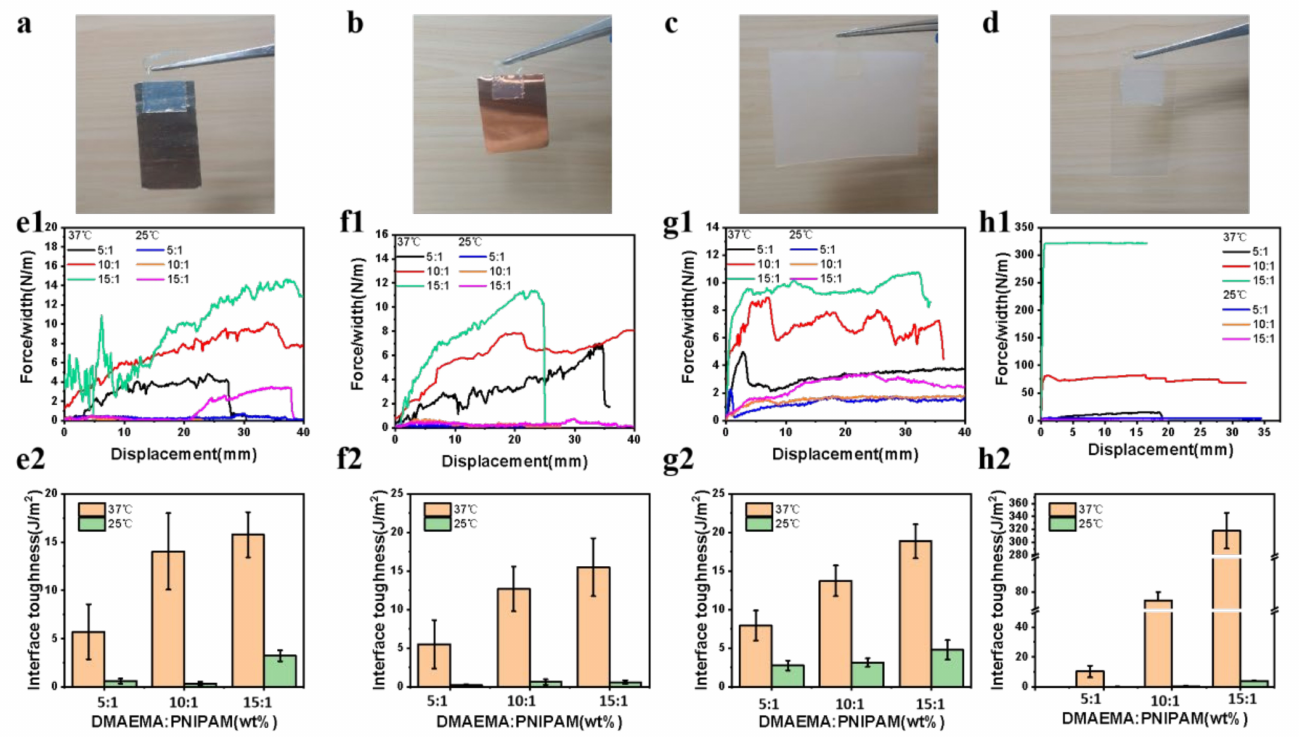
Figure 3. Adhesion performance of self-powered gradient hydrogel based on PDMAEAM/PNIPAM. Photos of hydrogels adhered on ( a ) platinum, ( b ) copper, ( c ) silicone rubber and ( d ) glass. ( e1 ) Peeling force curves and ( e2 ) interface toughness of hydrogel with different proportions at room temperature and high temperature in binding platinum; ( f1 ) peeling force curves and ( f2 ) interface toughness of hydrogel with different proportions at room temperature and high temperature in binding copper; ( g1 ) peeling force curves and ( g2 ) interface toughness of hydrogel with different proportions at room temperature and high temperature in binding silicone rubber; ( h1 ) peeling force curves and ( h2 ) interface toughness of hydrogel with different proportions at room temperature and high temperature in binding